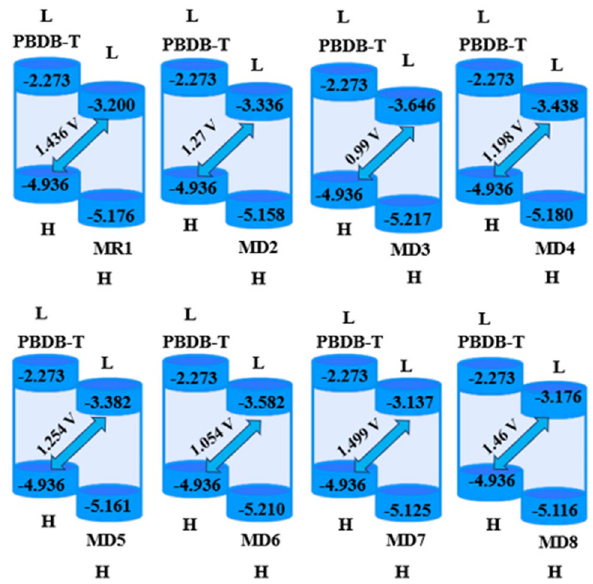
Figure 7. Diagrammatic illustration of V oc for investigated molecules drawn with the aid of power point. All out put files of entitled compounds were accomplished by Gaussian 09 version D.01 (https:// gauss ian. com/ g09ci